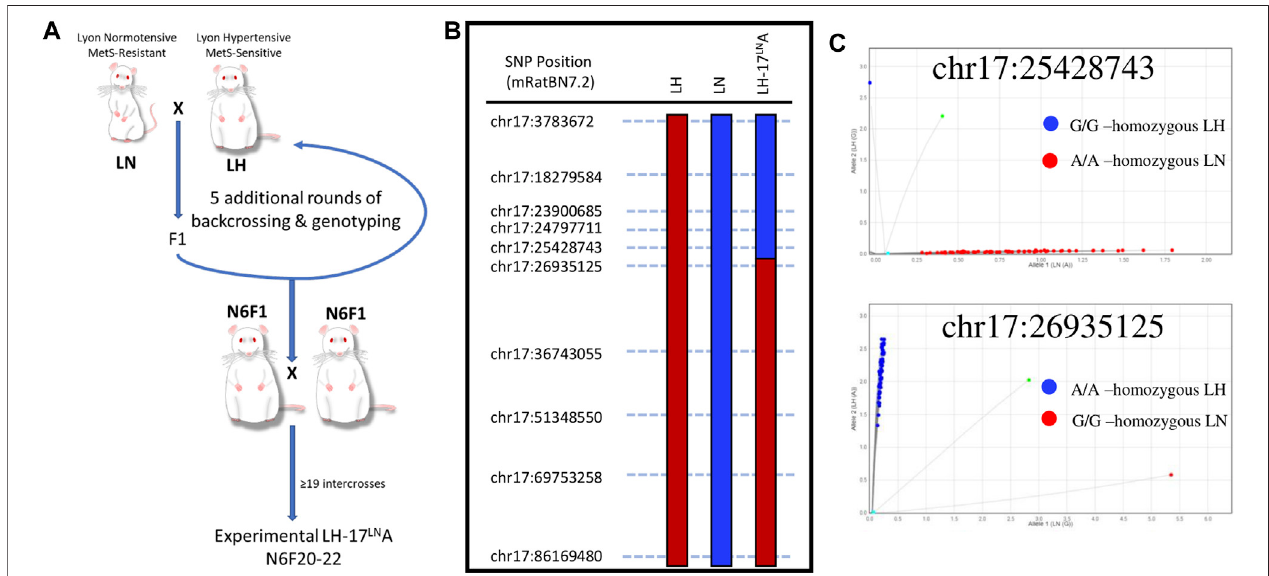
FIGURE 1 | Generation and validation ofa novel LH congenicrat tostudy the genomicbasis ofMetabolic Syndrome. (A) The LH.LN-Chr17 LN -(Fancc rgdv551196202- C -rs107291522)/Aekcongenicline(LH 17 LNa)wasgeneratedbycrossinganLHmalerattoanLNfemalerat,andthenbackcrossingF1malestofemalesoftheLHstrain. Between generations N1-N6, males were genotyped genome-wide before selection for breeding to rapidly fi x the genetic background (except for chromosome 17) for LH variants. Starting at N generation 6, male and female rats were intercrossed to homozygous animals for the chr17 region of interest. This strain was maintained by intercrossing in this manner until generation N6F20, before LH 17 LNa animals were enrolled for experiments. (B) The congenic line LH 17 LNa is de fi ned by their genotypes at the twelve SNPs throughout chr17, where animals are homozygous LN (blue) up to chr17:25428743 and homozygous LH (red) starting at chr17: 26935125. (C) FluorescentgenotypingcallsforthetwoSNPmarkersthatde fi netheboundaryoftheLH 17 LNacongeniccon fi rmthatallexperimentalanimalsusedinthis study were homozygous for the LN allele at position chr17:25428743 (top) and homozygous for the LH allele at position chr17:26935125 (bottom).